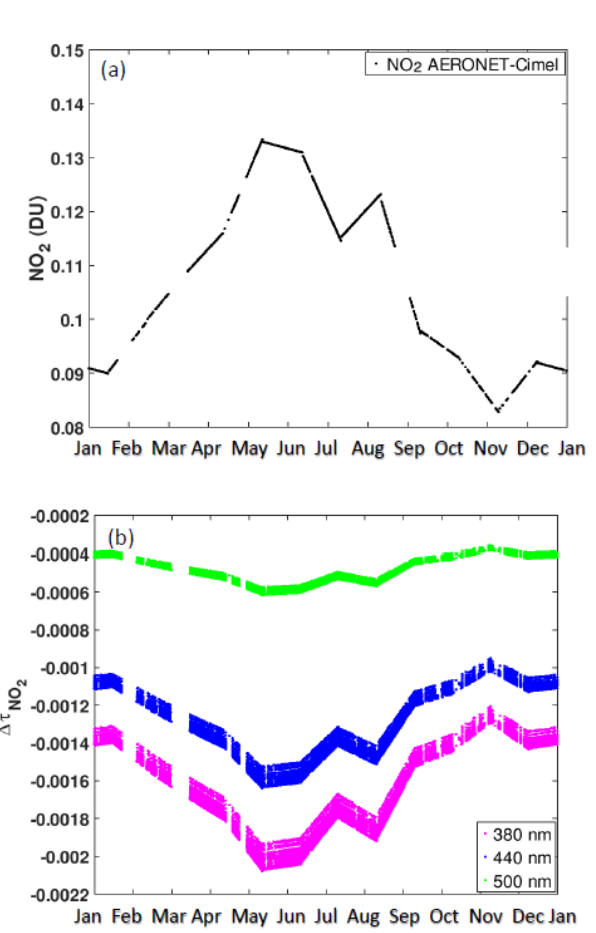
Figure 6. (a) NO 2 monthly climatology obtained from the ESA SCanning Imaging Absorption SpectroMeter for Atmospheric CHartographY (SCIAMACHY), used by AERONET-Cimel at IZO, and (b) (cid:49)τ NO caused by differences in daily total NO 2 between 2 GAW-PFR and AERONET-Cimel in the period 2005–2015. Note that GAW-PFR does not take into account the correction for the NO 2 absorption.